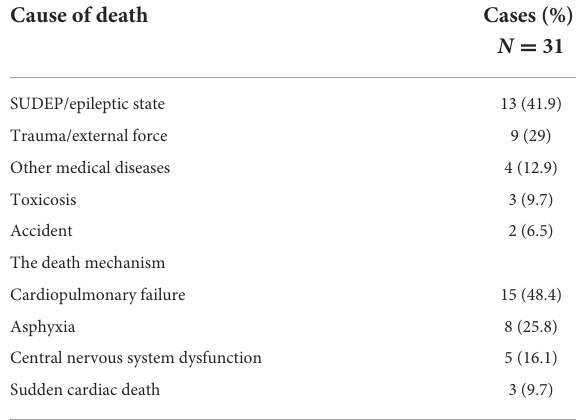
TABLE 3 Pathological findings of SUDEP cases. TABLE 4 The cause and mechanism of death of the SUDEP